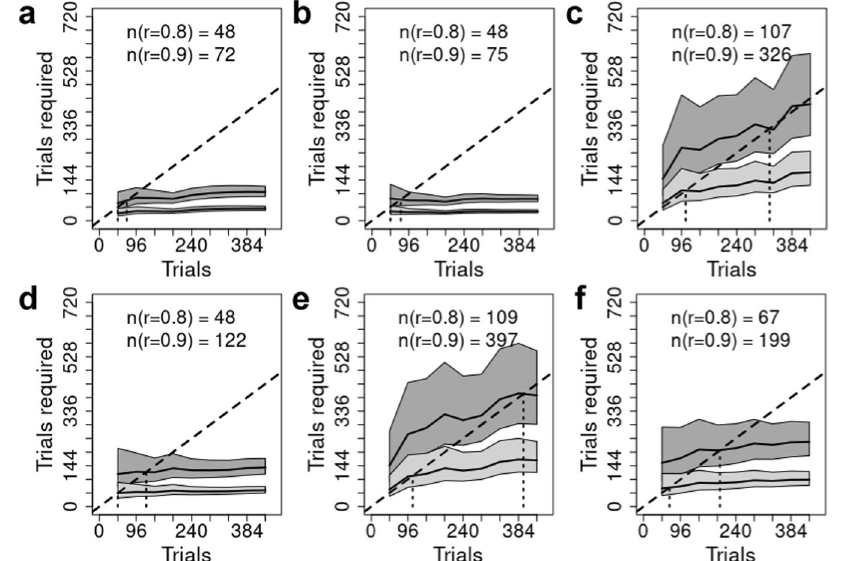
Fig. 7 | Trials required for reliable results. The total number of trials to achieve reliabilities ( r ) of 0.8 (lower line, light gray band) and 0.9 (upper line, dark gray band).Graybandsrepresenttheposteriormedian95%credibleintervals.Forevery point on the x-axis we are predicting the number of trials required to achieve a reliabilityof0.8(lightgrayregion)or0.9(darkgrayregion);thedottedverticalline